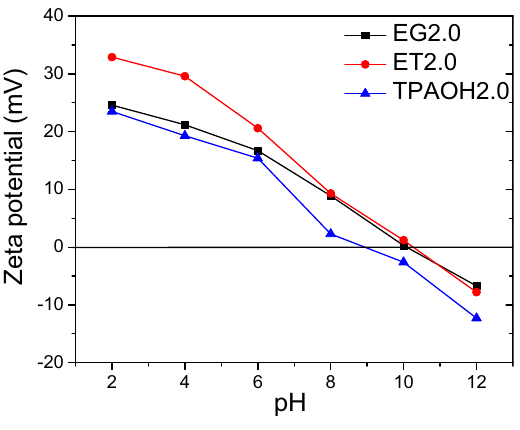
Figure 4: The zeta potential of EG2.0, ET2.0, and